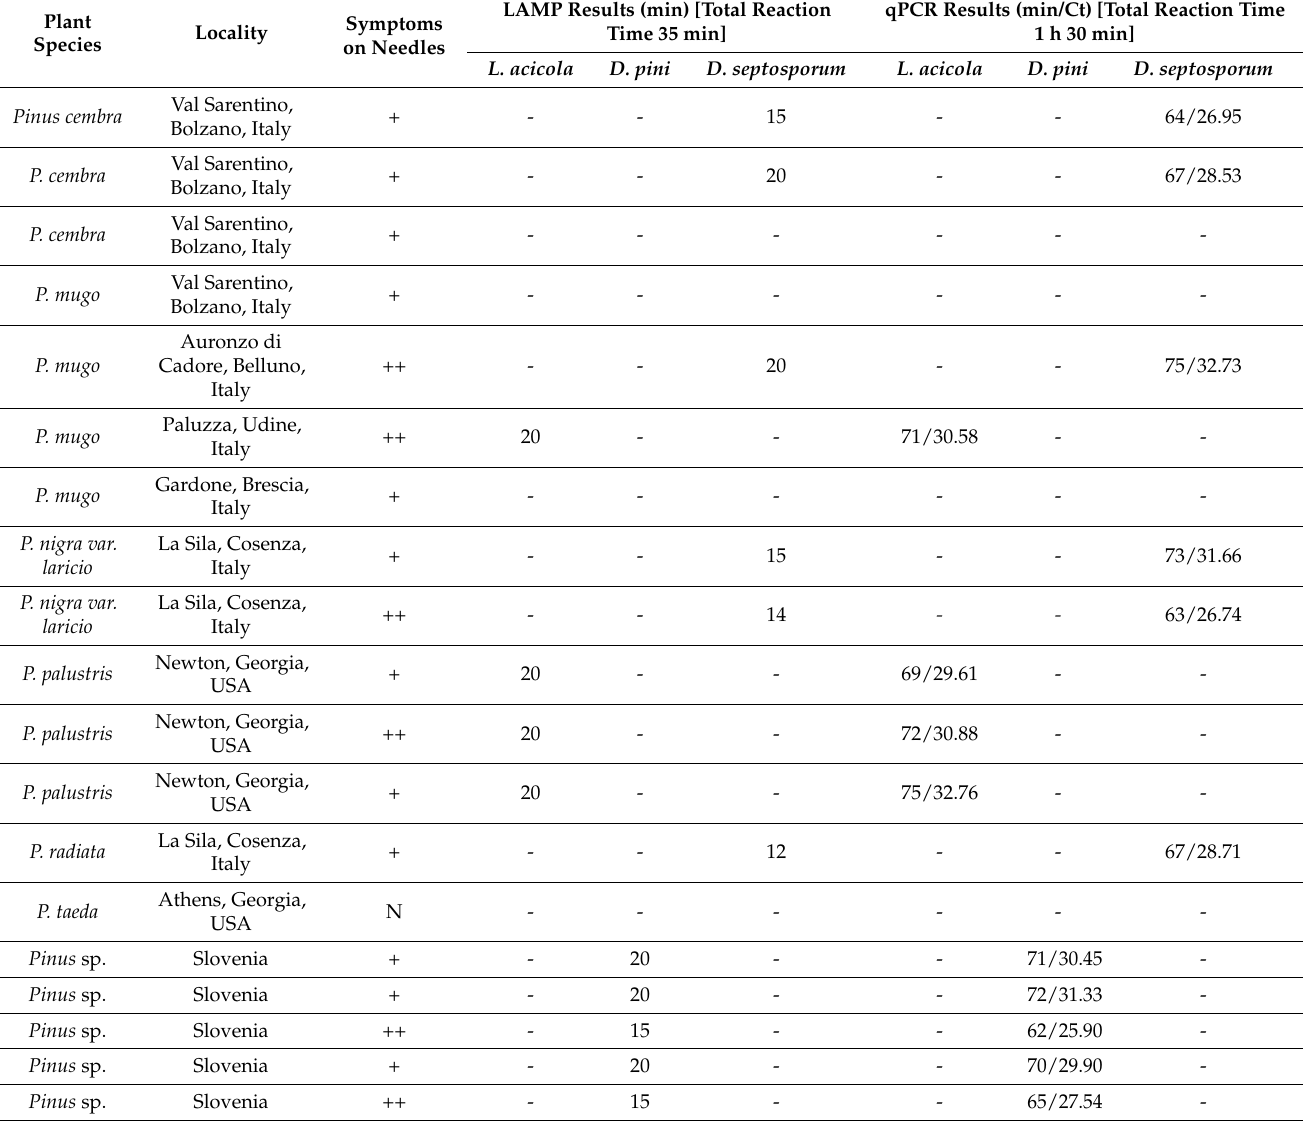
Table 2. Description of the pine needles samples tested with the three LAMP assays for the detection of Lecanosticta acicola, Dothistroma pini and D. septosporum , respectively, as well as with the qPCR assay described by [46]. LAMP results are shown as time of amplification (min) while qPCR results are shown as time of amplification (min) and cycle threshold (Ct). Negative result (-). Needles were classified as either fully symptomatic if they were discolored and bearing fruiting bodies (++), with incipient symptoms if they were only displaying discolored banding (+), or asymptomatic if they were displaying none of the above (N).